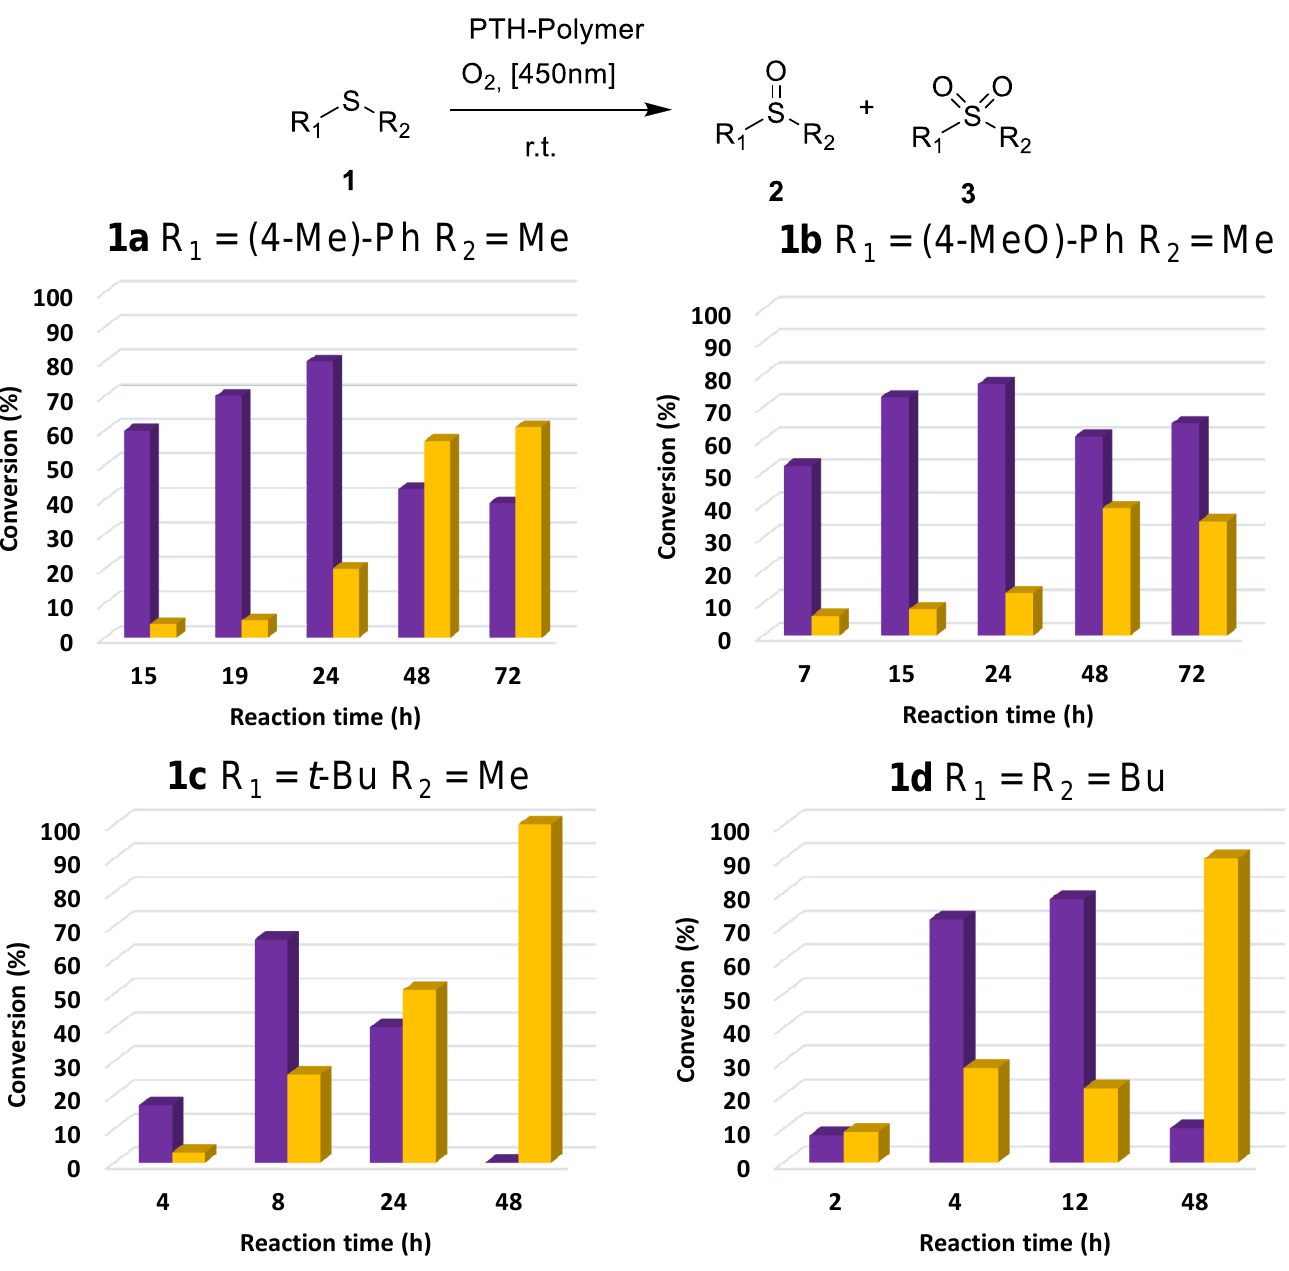
Figure 5. Yields of sulfoxides 2 (purple) and sulfones 3 (yellow), (measured by 1 HNMR Spectroscopy) resulting from solvent-free photocatalytic experiments at different reaction times using PTH-polymer as photocatalyst for sulfoxidation of substrate 1a ( top-left ), 1b ( top-right ), 1c ( bottom-left ) and 1d ( bottom-right ).